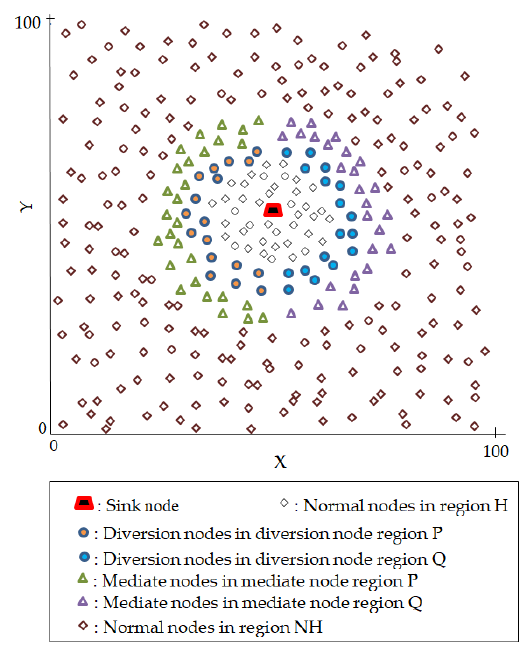
Figure 4. WSN domain and the strategic distribution of mediate and diversion nodes.